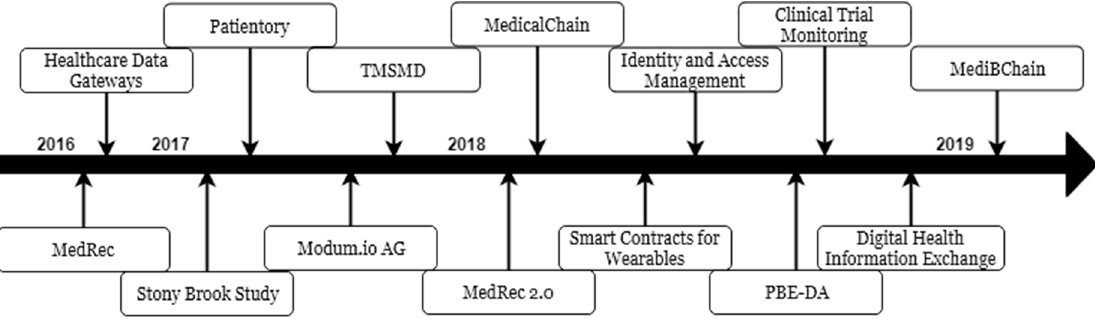
Figure 7. A timeline of the reviewed projects. Table 4. A summary of the reviewed projects